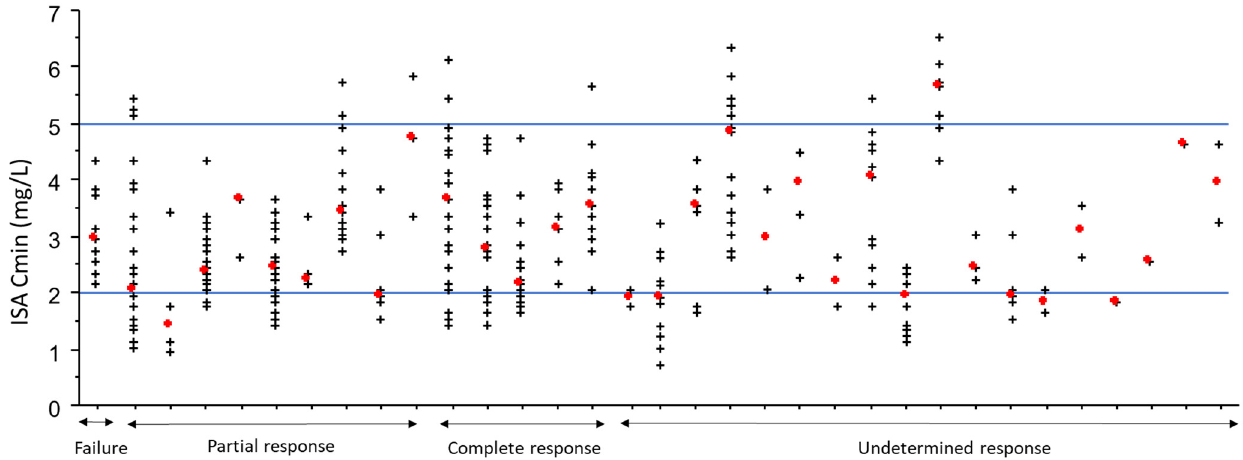
Figure 2. Variability of isavuconazole trough concentration (ISA Cmin) values for 33 patients ac- cording to the treatment response. Each vertical series of crosses corresponds to repeated ISA Cmin determinations for one patient, with the red cross indicating the median ISA Cmin per patient. Blue lines indicate the proposed therapeutic range at the Grenoble Alpes University Hospital.